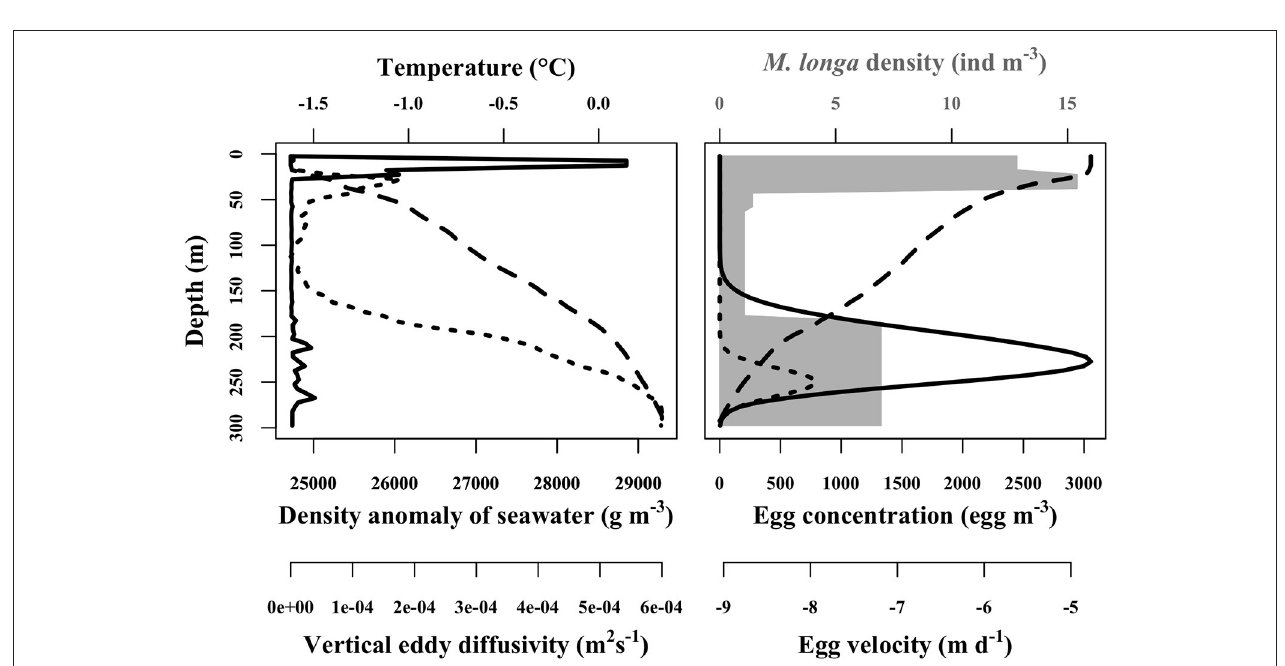
FIGURE 4 | Example of in situ physical forcing profiles from Amundsen Gulf used in the egg vertical distribution simulation (left panel). Solid line is the vertical eddy diffusivity (m 2 s − 1 ), dashed line is the density anomaly of seawater (g m − 3 ) and dotted line is the temperature ( ◦ C). Corresponding egg concentrations simulated for mean egg density (scenario D 0 ) of 19.4kg m − 3 are presented in the right panel. Dashed line is the egg velocity (m d − 1 ) computed according to Stokes’ law. Dotted line is at the initial condition corresponding to the spawned eggs profile. Solid line is the egg concentration distribution after 15 days of simulation. Gray area is the female M. longa abundance (ind m − 3